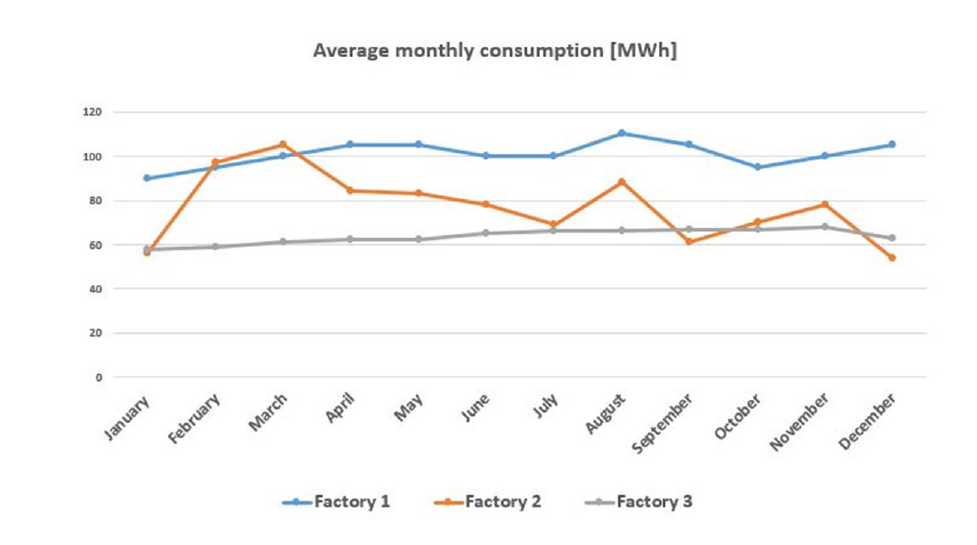
Figure 3. An example of average monthly consumption of three factories Purchasing electricity from the grid is the most costly choice available, whereas buying energy from the factory is the most economical option. Table 4 represents these TOU prices. Table 4. TOU prices of different energy sources TOU Prices Peak Off-Peak 0.18 P g t